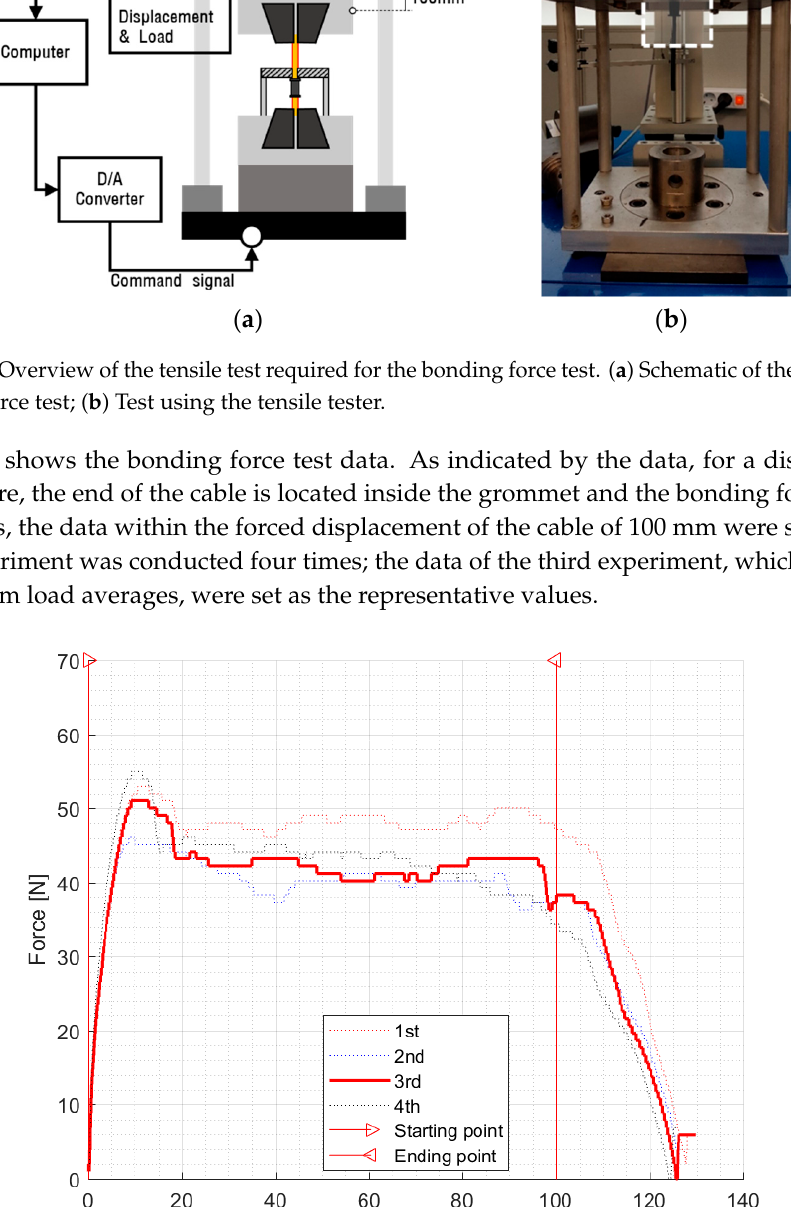
third experiment).